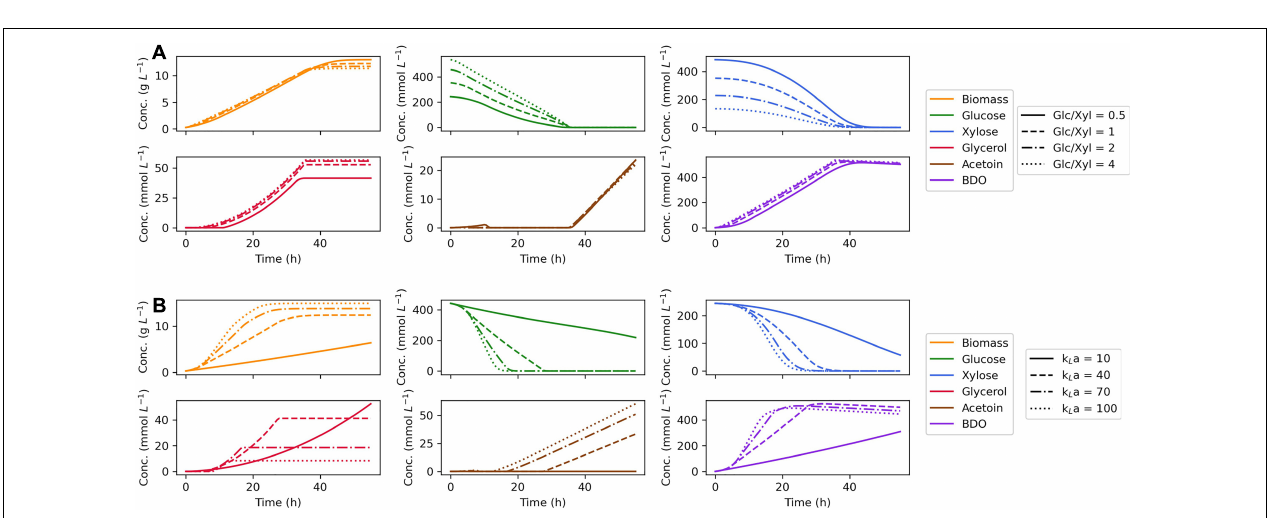
FIGURE 5 | Effects of initial substrate concentration ratio (A) and oxygen supply (B) on predictions of dynamic flux balance model. In the investigation of initial substrate concentration, a gradient of glucose:xylose ratios are tested keeping the total substrate C mol as a constant. Different agitation and oxygen supply levels are studied by varying the mass transfer coefficient (k L